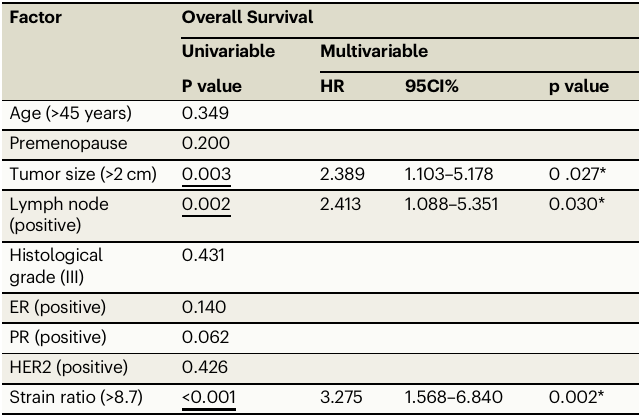
Table 2 | Cox regression analysis of overall survival in the treatment-naive cohort ( n = 388)